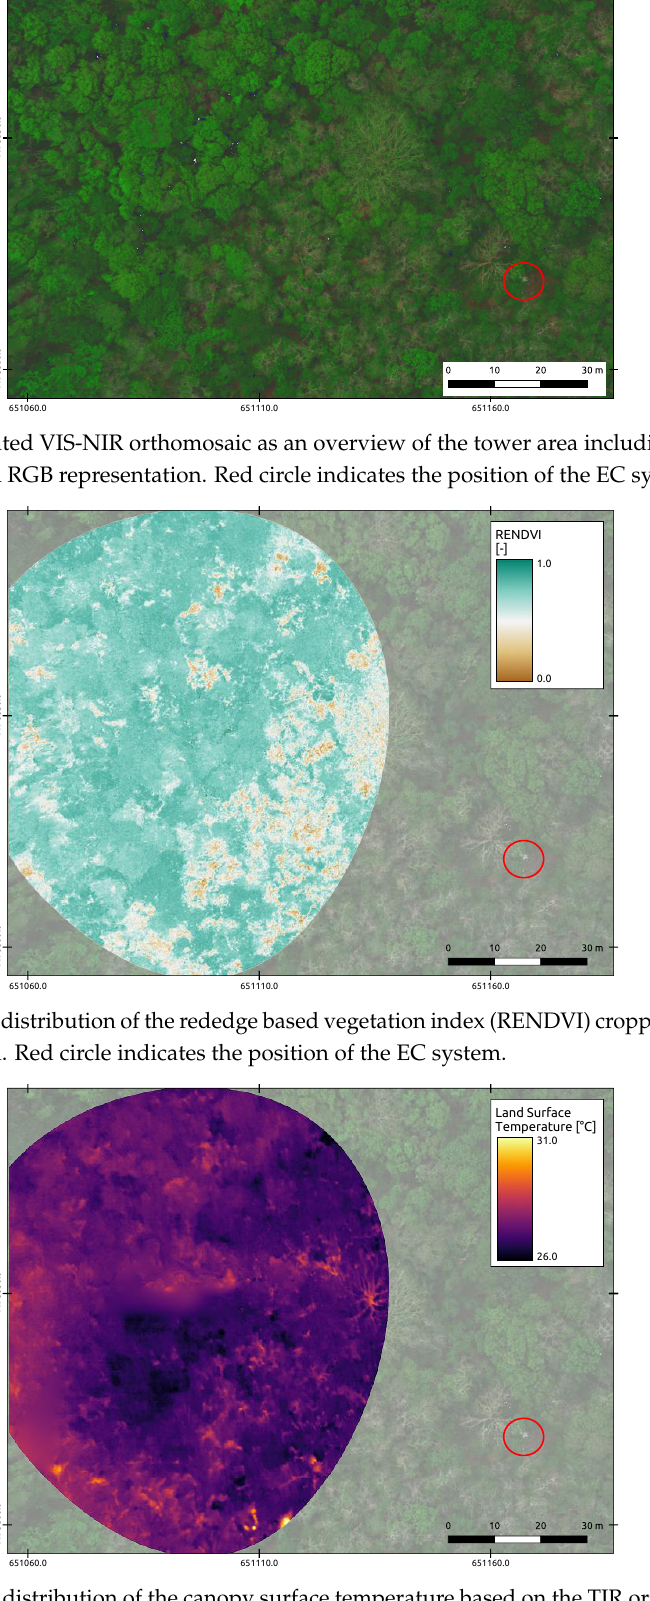
Figure 6. Spatial distribution of the canopy surface temperature based on the TIR orthomosaic cropped for the footprint of the EC system. Red circle indicates the position of the EC